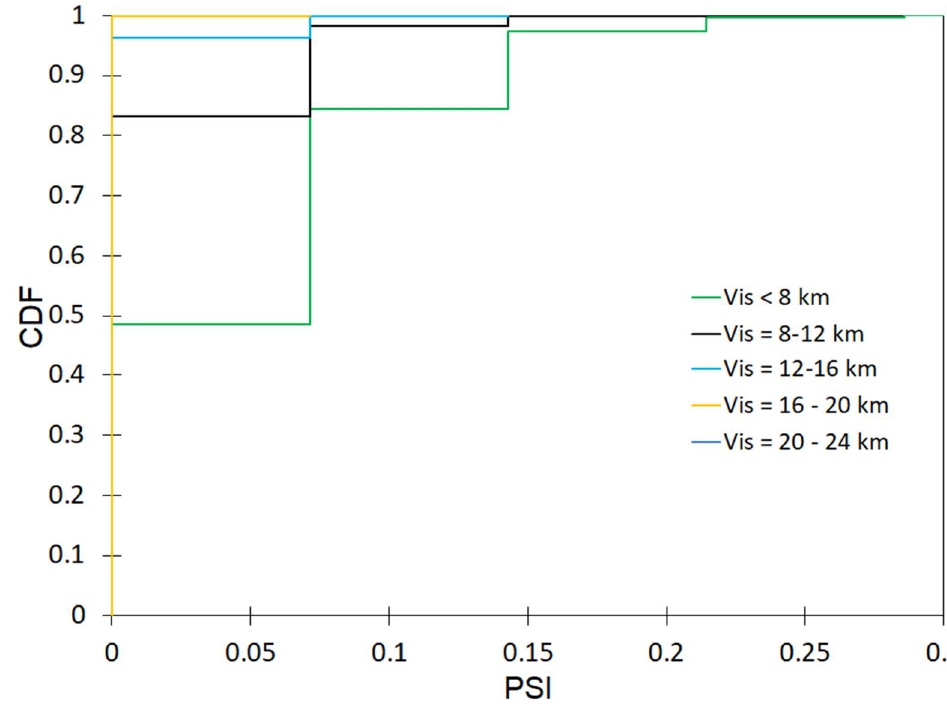
Figure A26. Effect of visibility on the incidence of high winter mortality for dry days.